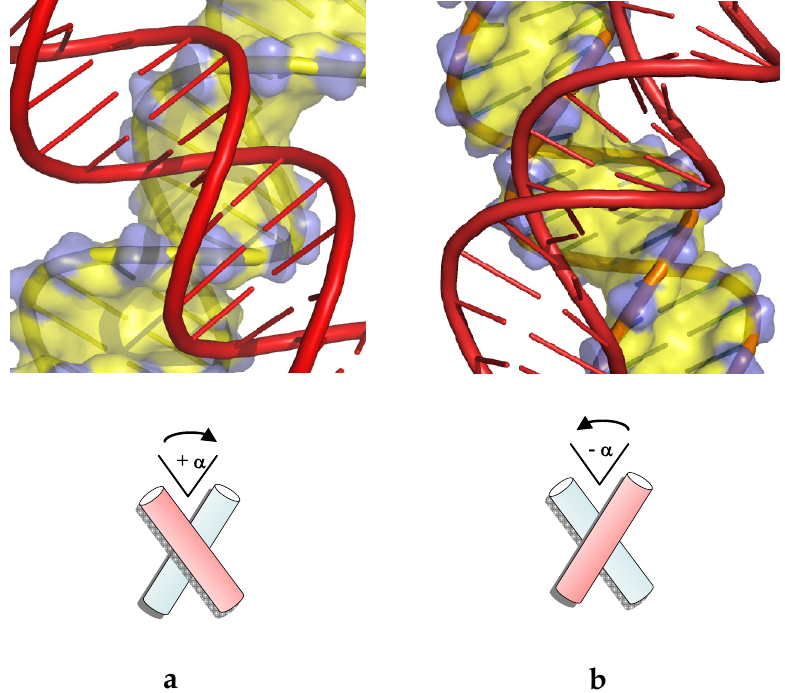
Figure 1. Chiral B-DNA crossovers. ( a ) Right-handed crossover assembled by the mutual fit of the backbones into the major-groove; ( b ) Left-handed crossover assembled by major groove-major groove